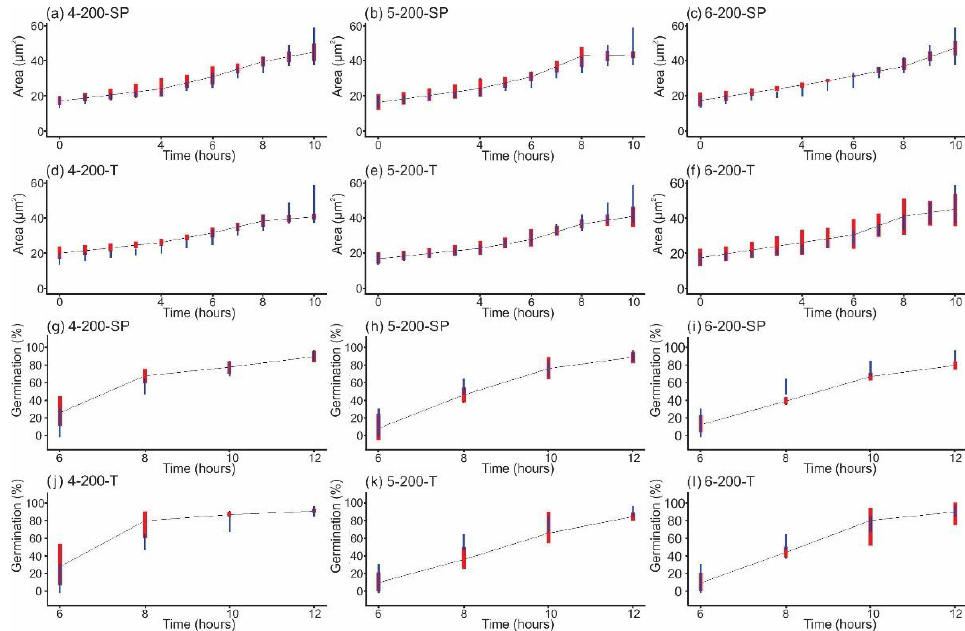
Figure 4. Swelling of conidia versus time after exposure to 200 single-pulse (SP) shock waves generated at ( a ) 4 kV, ( b ) 5 kV, and ( c ) 6 kV, and to 100 tandem (T) events (200 shock waves), generated at ( d ) 4 kV, ( e ) 5 kV, and ( f ) 6 kV. Moreover, it shows the percentage of conidia that formed a germ tube after being exposed to 200 SP shock waves generated at ( g ) 4 kV, ( h ) 5 kV, and ( i ) 6 kV, and to 100 tandem (T) events (200 shock waves) generated at ( j ) 4 kV, ( k ) 5 kV, and ( l ) 6 kV. The graphs resulted from dots corresponding to the average of 100 conidia measured. Vertical red lines represent 95% bootstrap intervals of the growth of shock-wave-treated conidia, and vertical blue lines refer to the 95% bootstrap interval of the control experimental groups. Overlapping intervals indicate a nonsignificant difference.